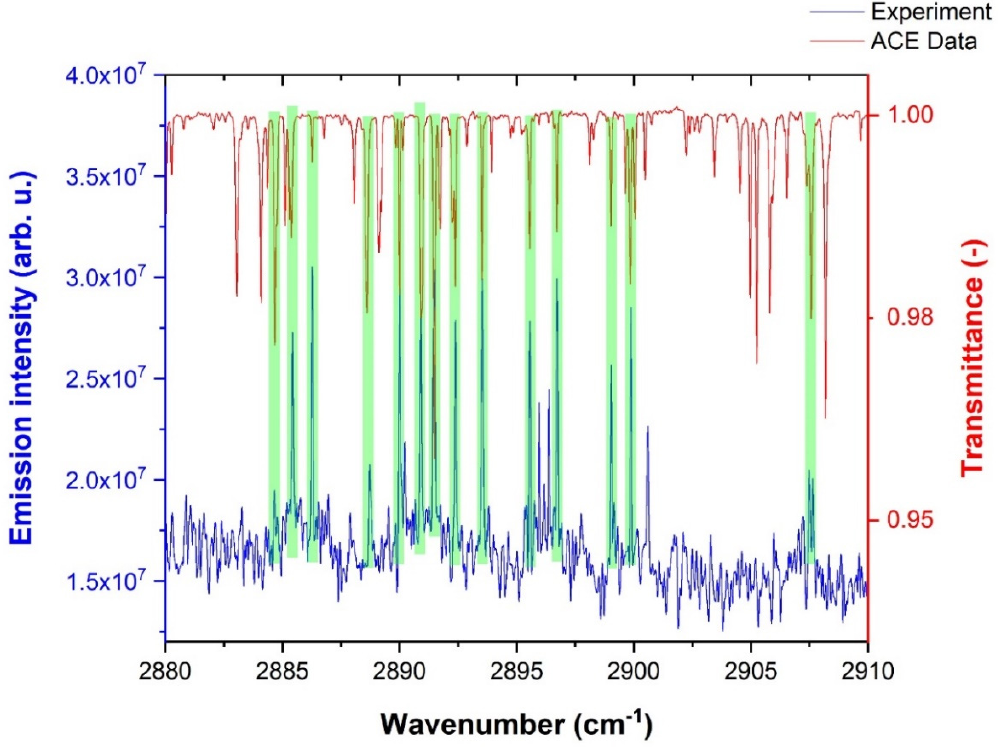
Figure 7. Comparison of experimentally observed rovibrational OH emission lines with the ACE solar spectrum.